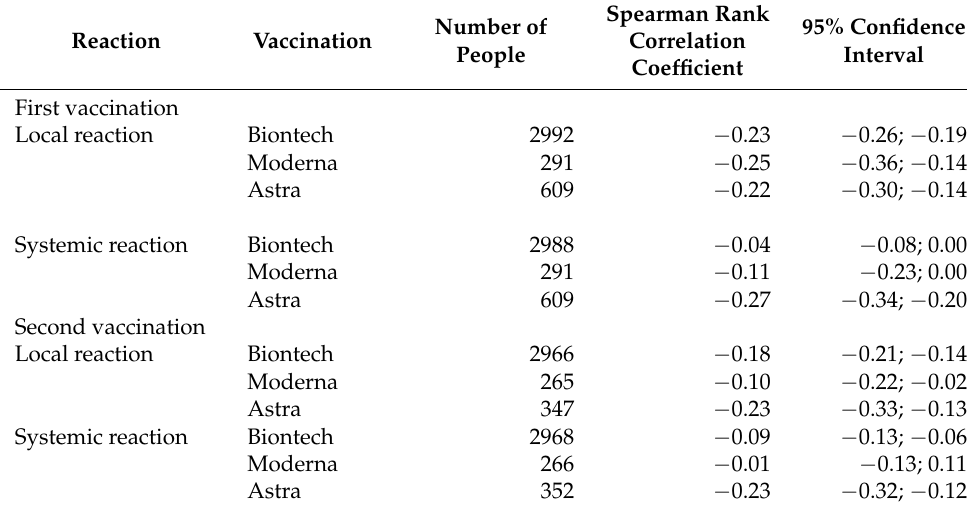
Legend Table: 95% confidence intervals by Fisher’s